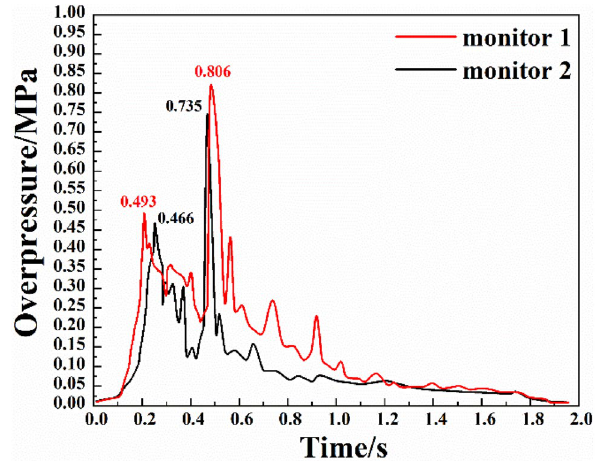
Figure 4. Overpressure change of bifurcation